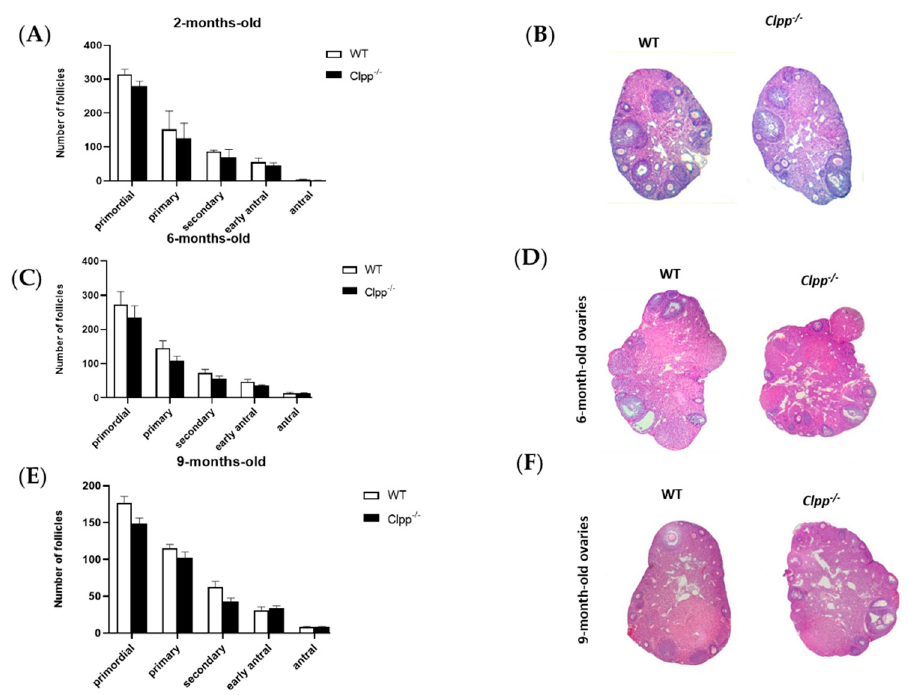
Figure 2. Assessment of follicle development in mice with targeted deletion of Clpp in granulosa cells. ( A , C , E ) Follicle development was assessed in 2-, 6-, 9-month-old Clpp − / − and WT mice ovaries (both ovaries of three different mice were assessed in each group, and for each timepoint). Data presented as mean ± SEM. ( B , D , F ) Representative micrographs of 2-, 6-, 9-month-old Clpp − / − and WT mice ovarian sections stained with hematoxylin and eosin.